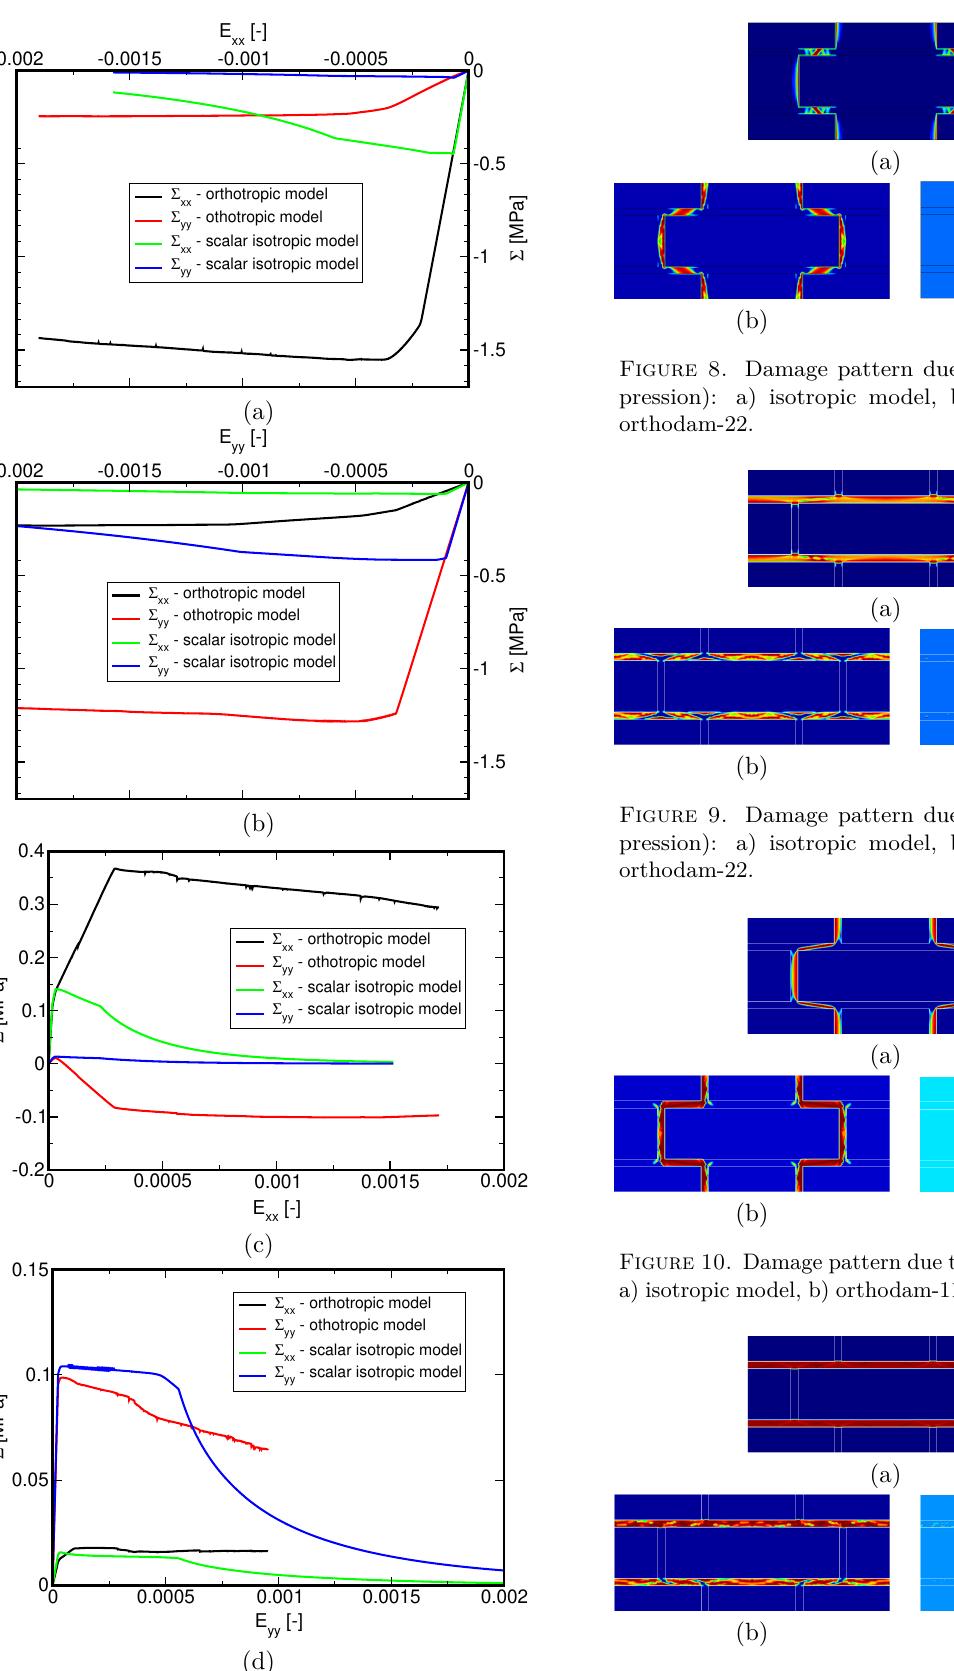
Figure 7. Macroscopic stress-strain curves: a) com- pression ( E xx < 0) applied in X direction, b) com- pression ( E yy < 0) applied in Y direction, c) tension ( E xx > 0) applied in X direction, d) tension ( E yy > 0) applied in Y direction.